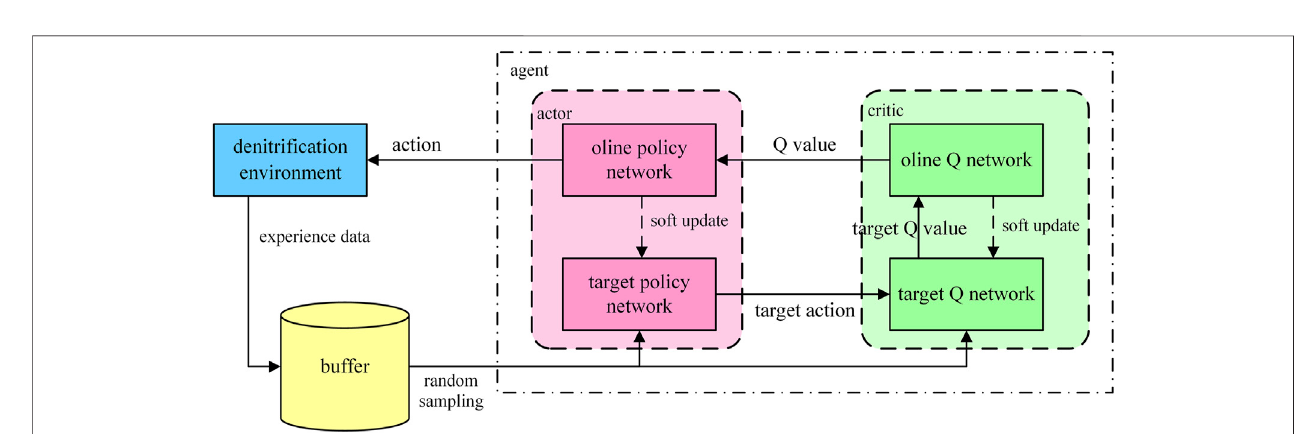
FIGURE 8 | DDPG algorithm fl ow